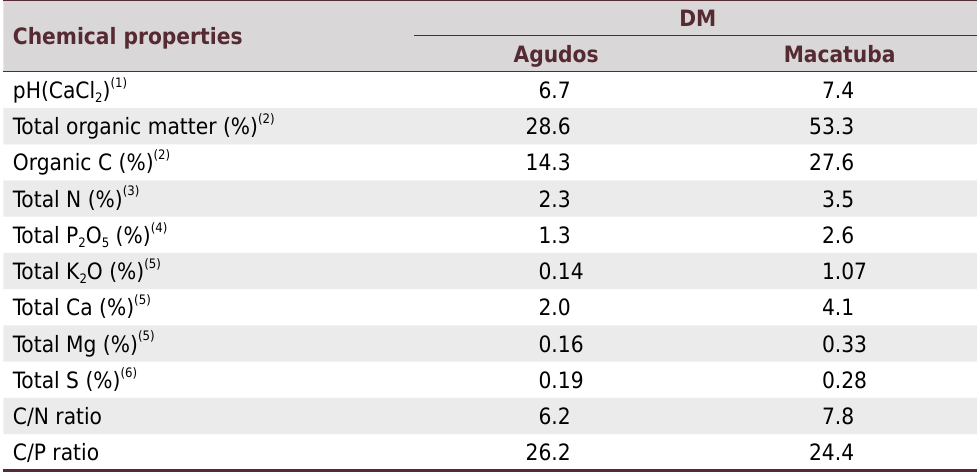
destilation; (4) Vanadate/molybdate method; (5) Atomic absorption spectrometry; (6) Gravimetry/Barium chloride. DM = mass dried at 65